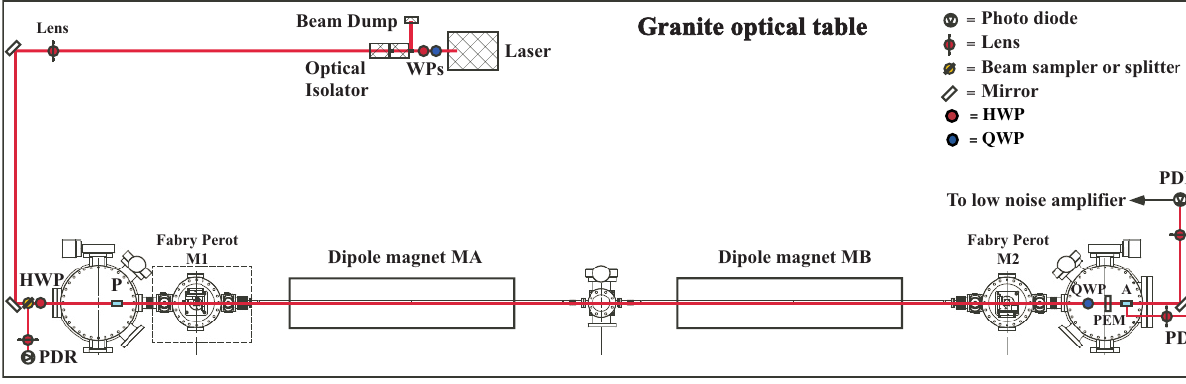
Figure 15. Schematic view of the optical bench layout of the PVLAS-FE apparatus. The laser beam enters the polarizing vacuum chamber ( left ) containing the polarizer P after having been properly aligned and focused. It then passes through the mirrors M1 and M2 of the Fabry–Perot and the magnets. The analyzing chamber ( right ) contains in order an extractable QWP (shown inserted) for rotation measurements, the PEM ellipticity modulator and the analyzer A with an extra lateral output. HWP = Half-wave plate; QWP = quarter-wave plate; PDT = transmission signal I (cid:107) ; PDE = extinction signal I ⊥